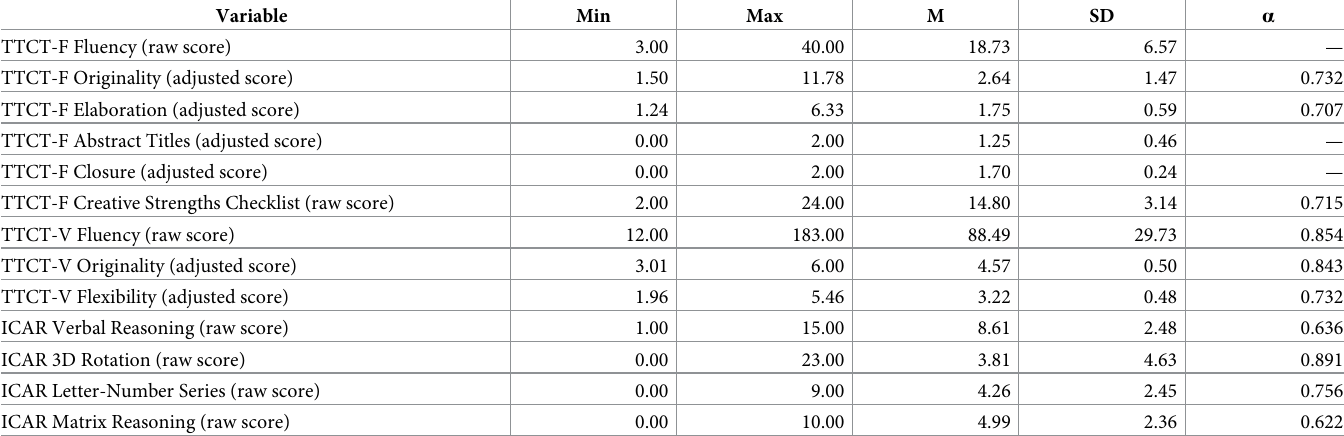
Table 2. Descriptive statistics of variables used in the CFA models.